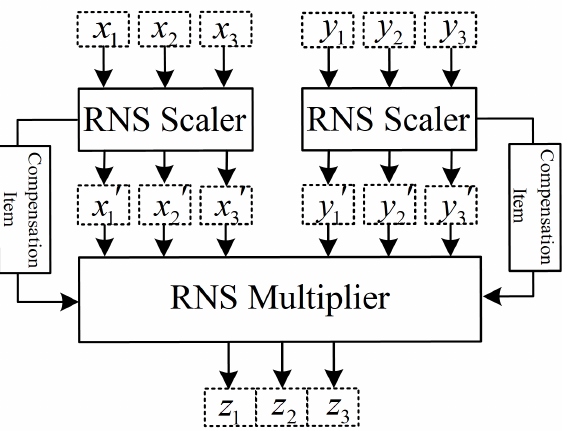
Figure 2. The proposed high precision overflow-free RNS multiplier